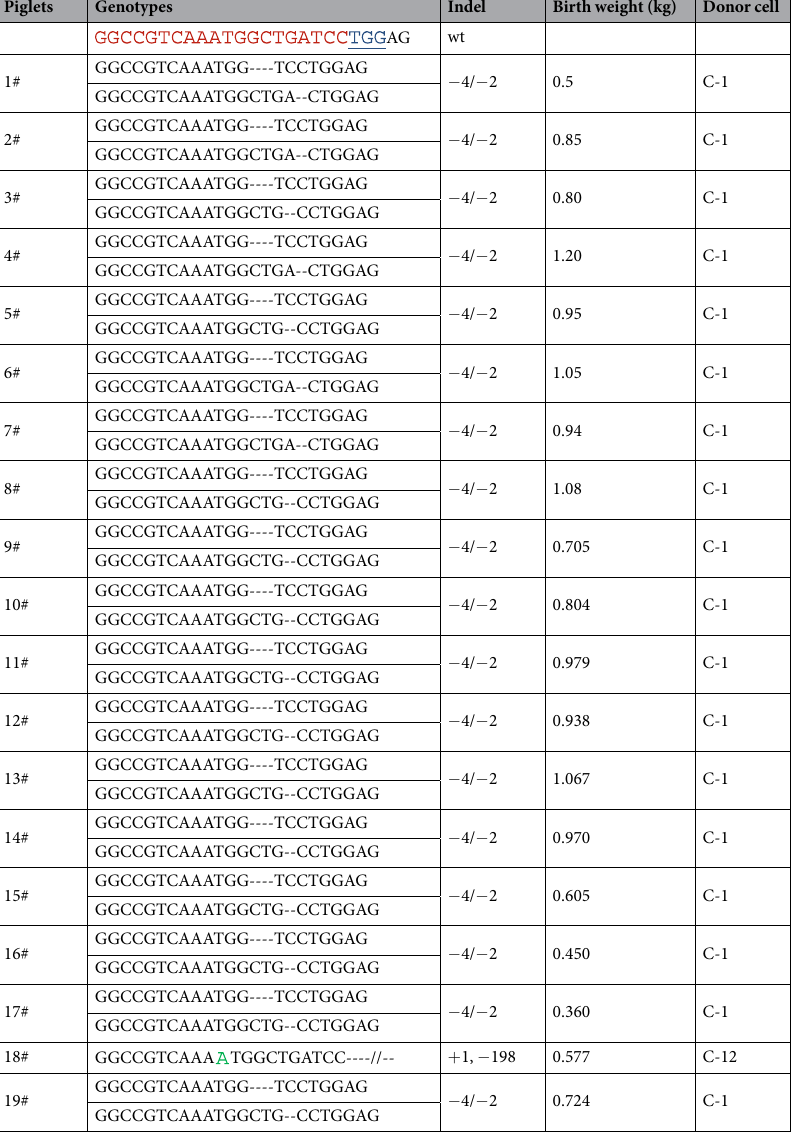
Table 3. Details on the generated C3 KO piglets. sgRNA sequences are highlighted in red, PAM sequences in blue, and insertions in green. WT: wild type; deletion ( − ); insertion: ( +